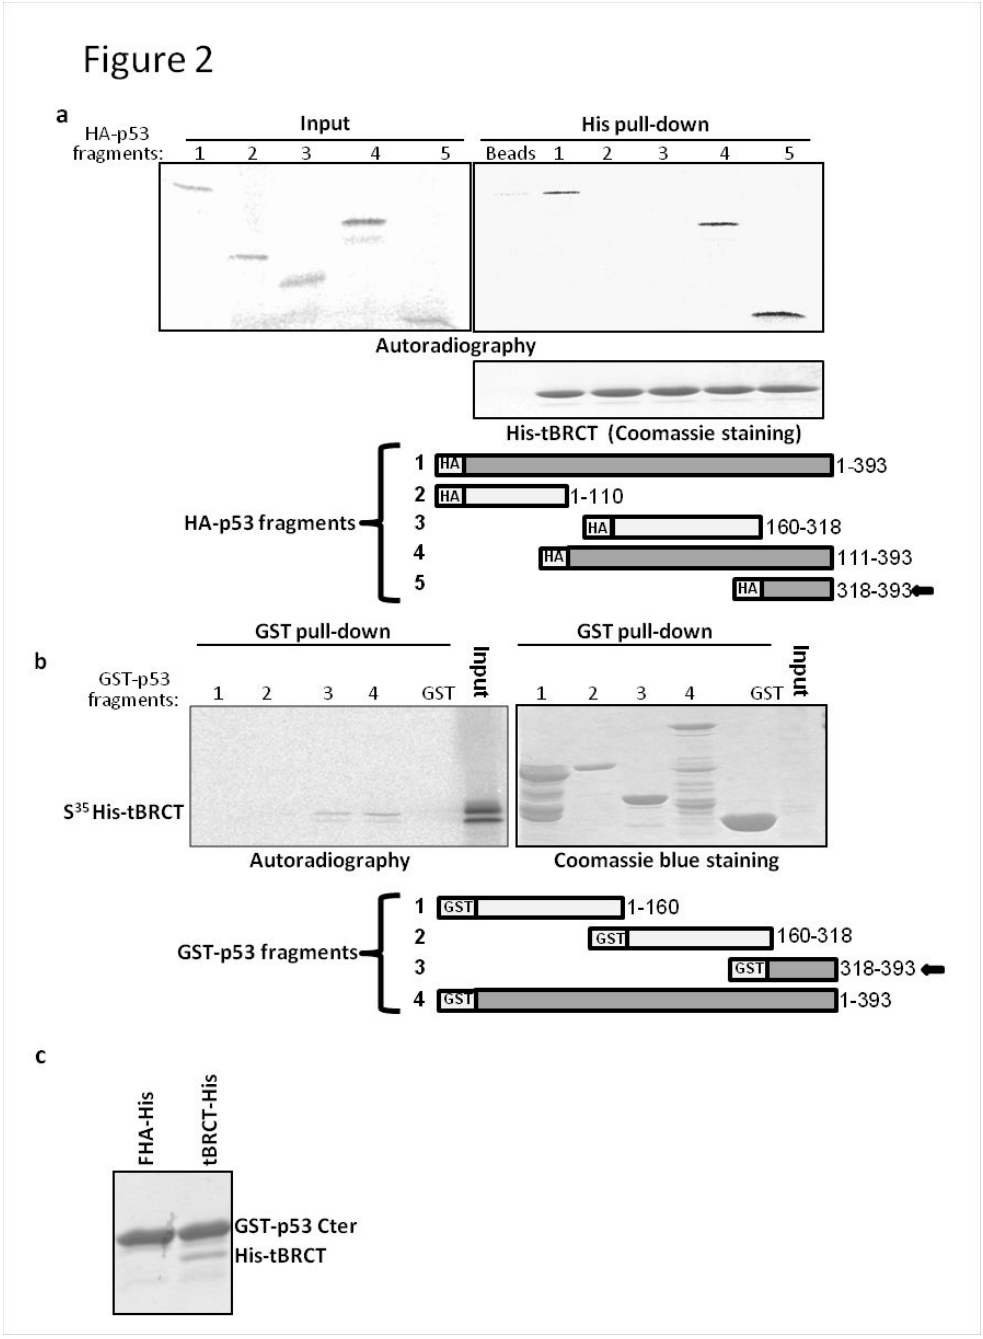
Figure 2. A C-terminus region (a.a. 318-393) of p53 directly binds MDC1-tBRCT. (a) His-tBRCT retrieves p53 fragments consisting a.a. 318-393: Bacterially expressed His-tBRCT was incubated with different radio-labeled fragments of p53-HA expressed in reticulocytes (for details see schematic representations below). Following His pull-down reactions the labeled p53 fragments (in the input or those retrieved by His-tBRCT) were visualized by autoradiography. (b) p53 fragments containing a.a 318-393 bind tBRCT-MDC1: Fragments of p53 fused to GST (for details see schematic representations below) were expressed in bacteria and purified. Following incubation with radio-labeled His-tBRCT and GST pull-down reactions, His-tBRCT visualized by using autoradiography. Input is 5% of His-tBRCT added to the reaction. The same gels were used for autoradiography and Coomassie blue staining in B. (c) GST pull-down using a.a. 318-393 of p53 fused to GST (GST-p53Cter) for His-FHA or His-tBRCT, followed by Coomassie blue staining. doi: 10.1371/journal.pone.0078472.g002 PLOS ONE |